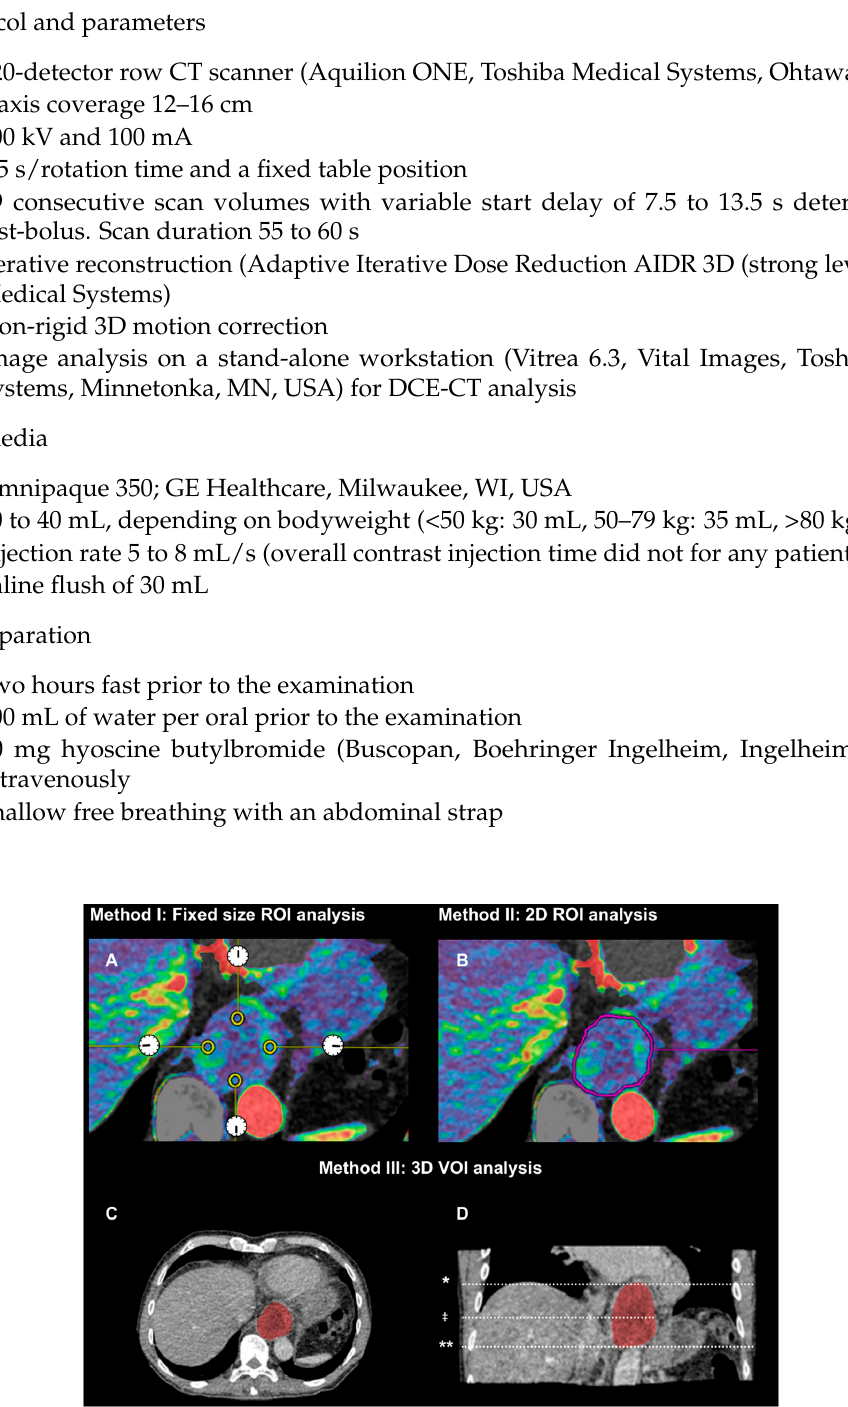
List 1. Scan parameters, contrast media administration and patient preparation.